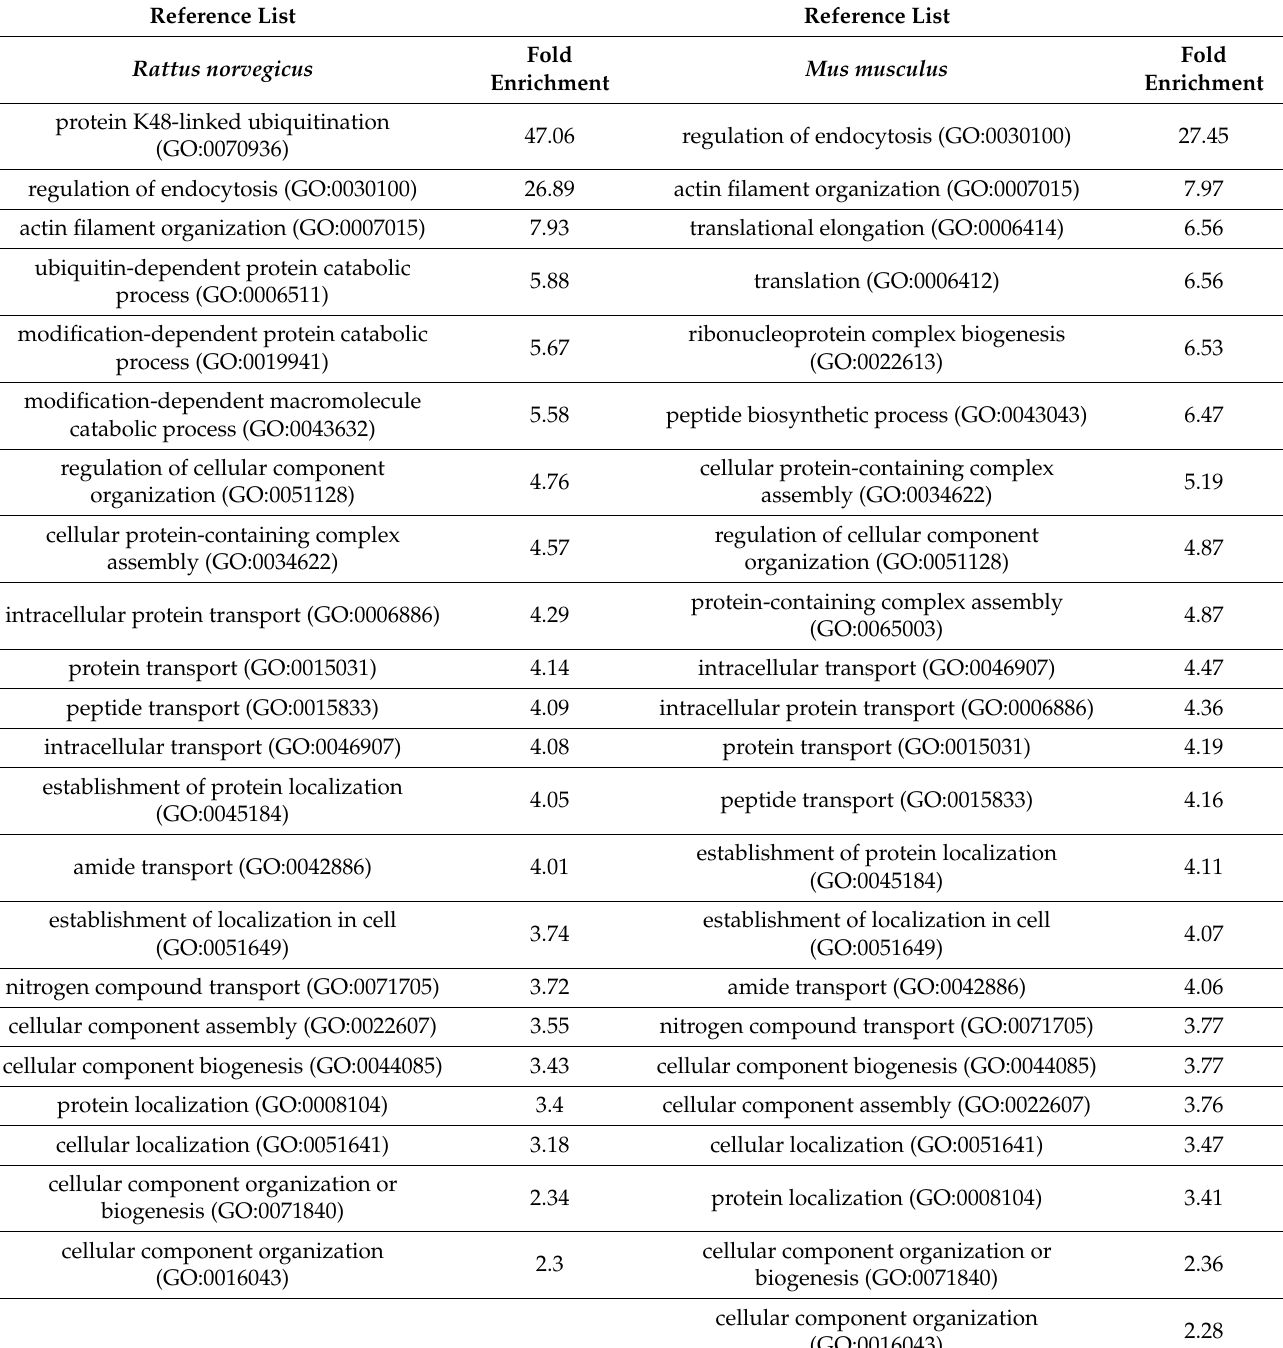
Table 4. PANTHER GO-Slim biological process